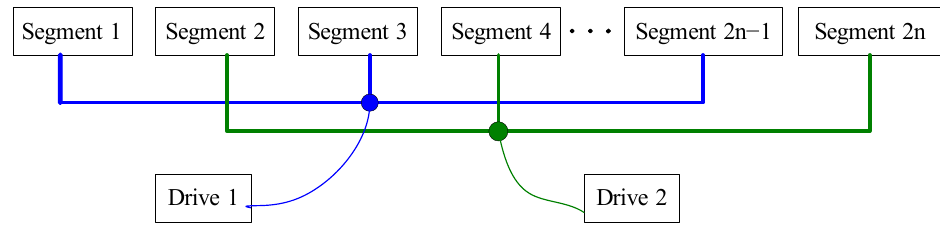
Figure 1. The diagram of the drive of the WS-PMLM.